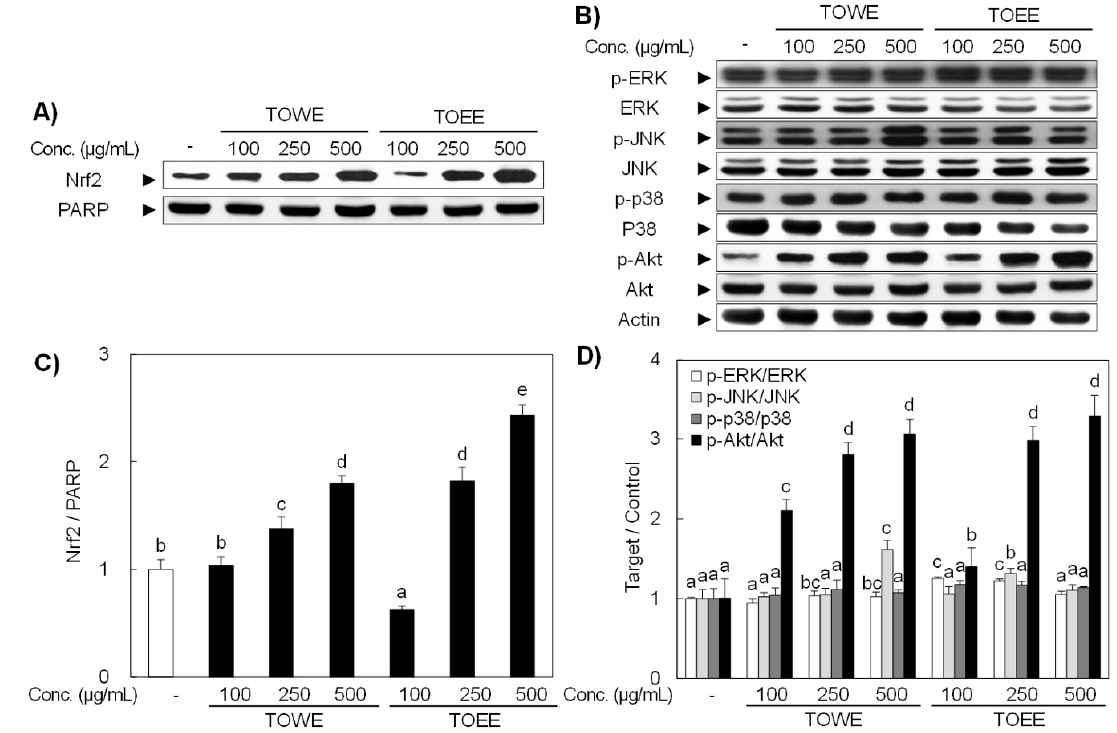
Figure 3. TOWE and TOEE induced nuclear translocation of Nrf2 as well as HO-1 expression through the regulation of JNK and PI3K / Akt signaling pathways in RAW 264.7 cells. ( A ) RAW 264.7 cells were treated with various concentrations of TOWE and TOEE for 12 h. Then, the translocated status of Nrf2 was determined from the nuclear extract by Western blot analysis. ( B ) The cells were treated with indicated doses for 4 h to activate signaling molecules. TOWE triggered the phosphorylation of JNK and Akt, while TOEE only phosphorylated Akt in RAW 264.7 cells. The phosphorylated status of MAPKs and Akt were also analyzed by Western blot analysis. ( C , D ) The relative induction ratio of the Nrf2 and HO-1 expression was quantified by densitometry as well as PARP and actin were used as internal controls. The data represent the mean ± SD of triplicate experiments. The values sharing the same superscript are not significantly di ff erent at p < 0.05 by Duncan’s multiple range test. Nrf2, nuclear factor-erythroid 2 p45-related factor 2; PARP, poly (ADP-ribose) polymerase; ERK, extracellular signal-regulated kinase; JNK, c-Jun NH 2 -terminal kinase.